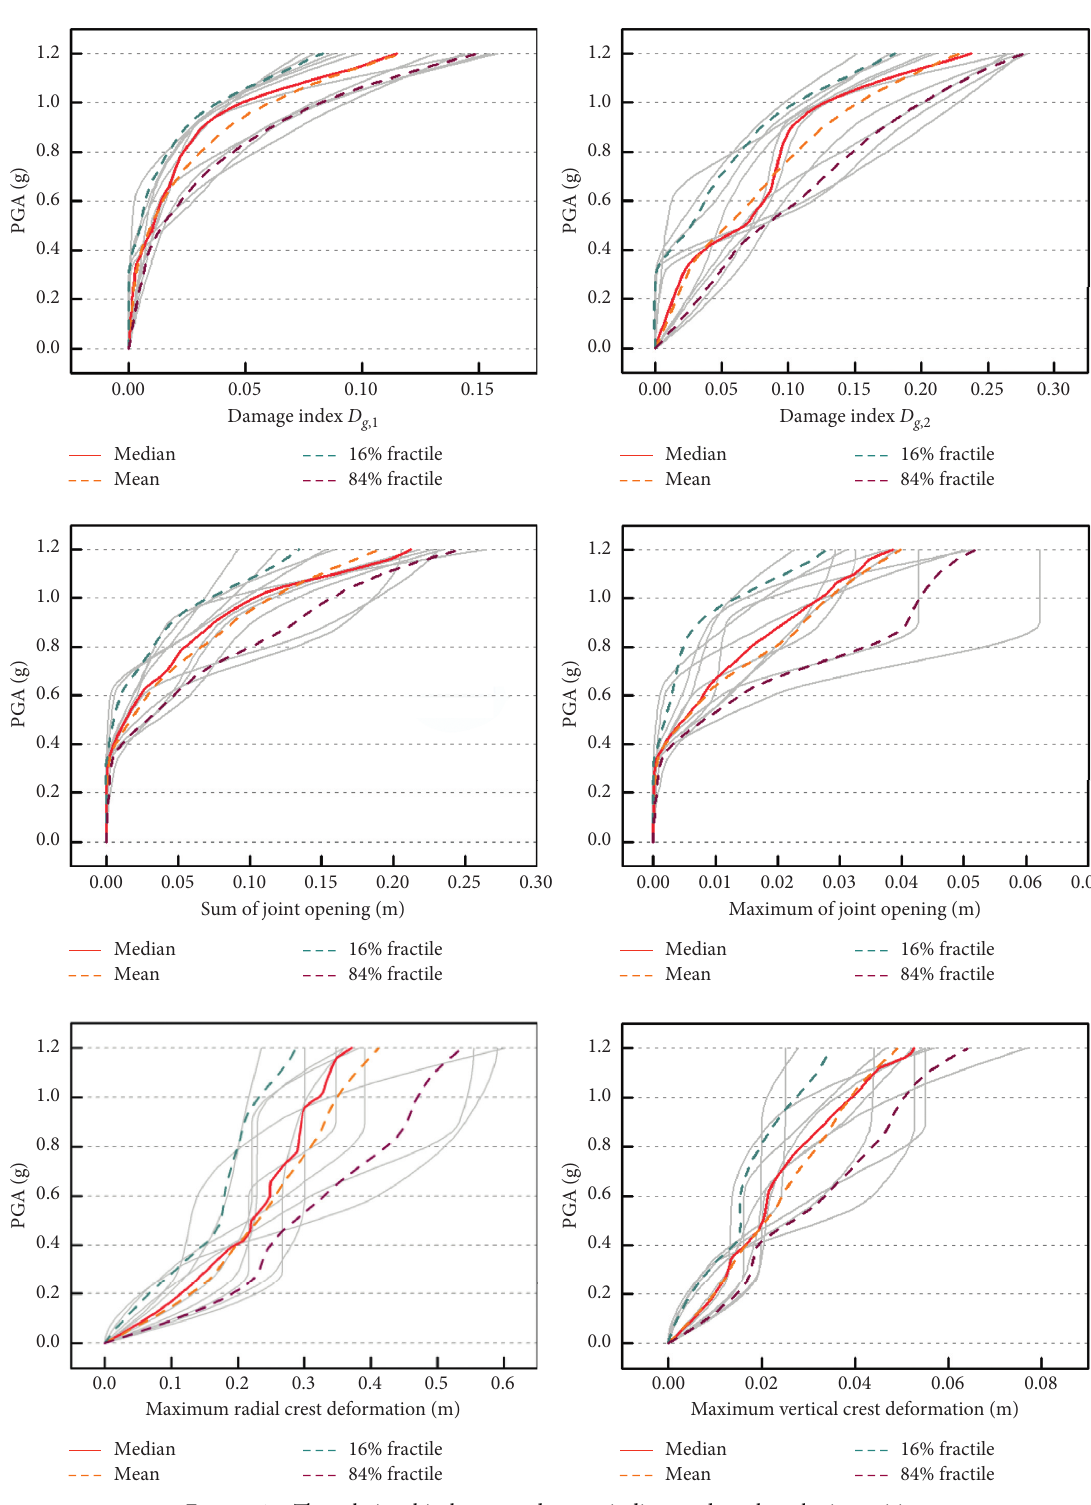
Figure 17: The relationship between damage indices and earthquake